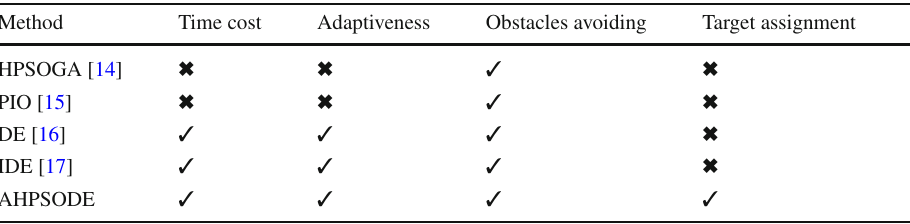
Table 1 Comparison of different methods for formation